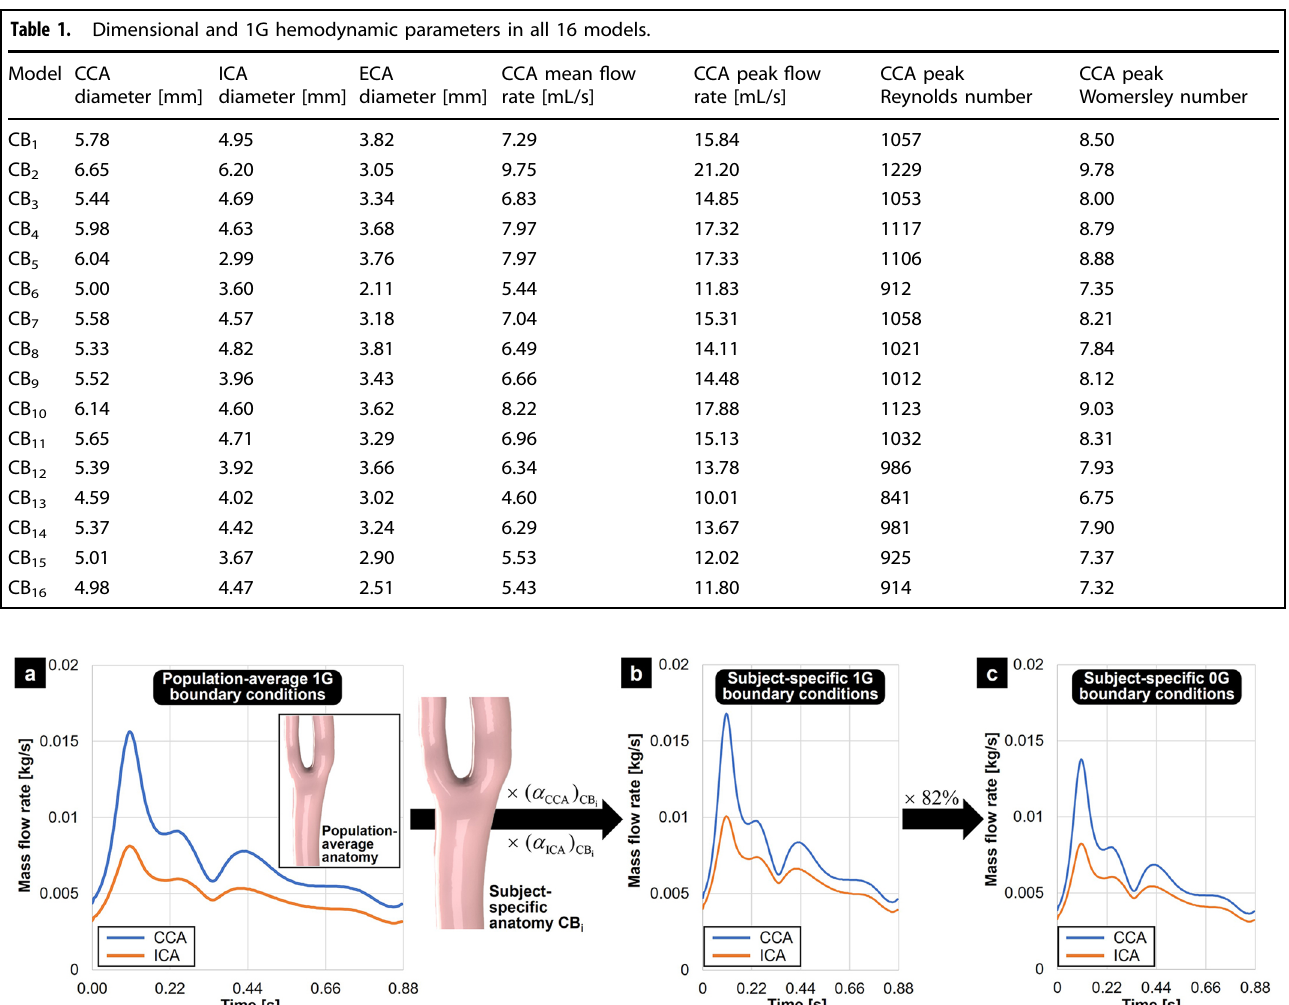
Fig. 7 Strategy implemented to generate subject-speci fi c 1G and 0G boundary conditions. a Reference 1G CCA and ICA mass fl ow rate conditions (adapted from Lee et al. 50 ) were scaled based on the CCA and ICA diameters measured in each anatomical model to yield ( b )